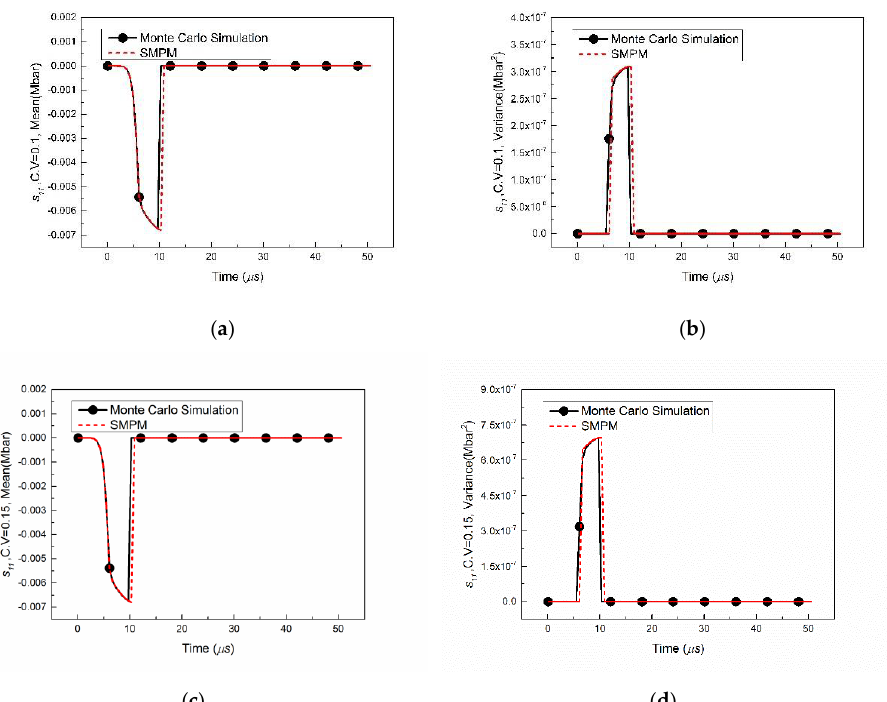
Figure 11. Deviatoric stress S 11 response of location G by various methods with C.V = 0.1 and C.V = 0.15: ( a ) Mean of S 11 with C.V = 0.1; ( b ) Variance of S 11 with C.V = 0.1; ( c ) Mean of S 11 with C.V = 0.15; ( d ) Variance of S 11 with C.V = 0.15.